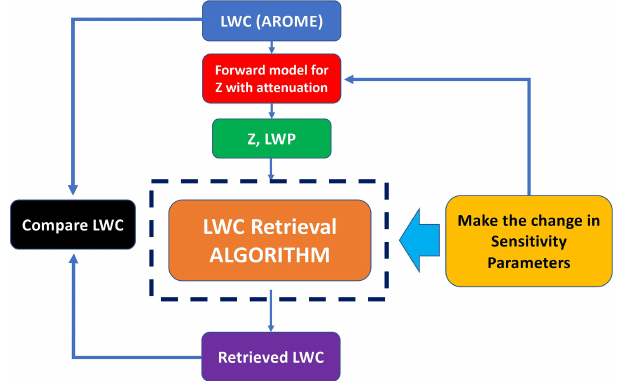
Figure 3. Flow chart for sensitivity analysis of retrieval algorithm. The block inside the dashed line is the same as shown inside the dashed line in Fig. 1 with all the sensitivity